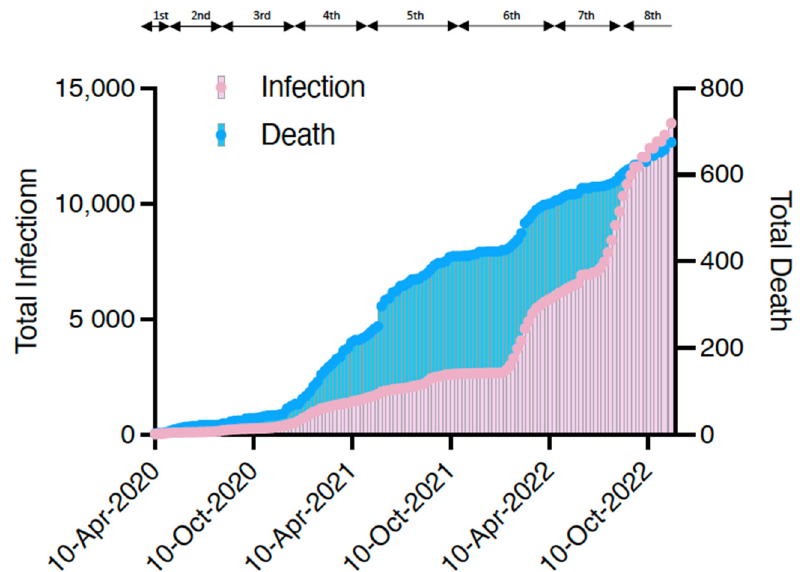
Figure 1. The total number of infected patients undergoing dialysis in Japan and the number of deaths. The periods of the first to eighth waves (the 8th wave is ongoing) are also shown. Data were taken from the website of the Japanese Association of Dialysis Physicians (http://www.touseki-ikai.or.jp/, accessed on 7 December 2022) and plotted.